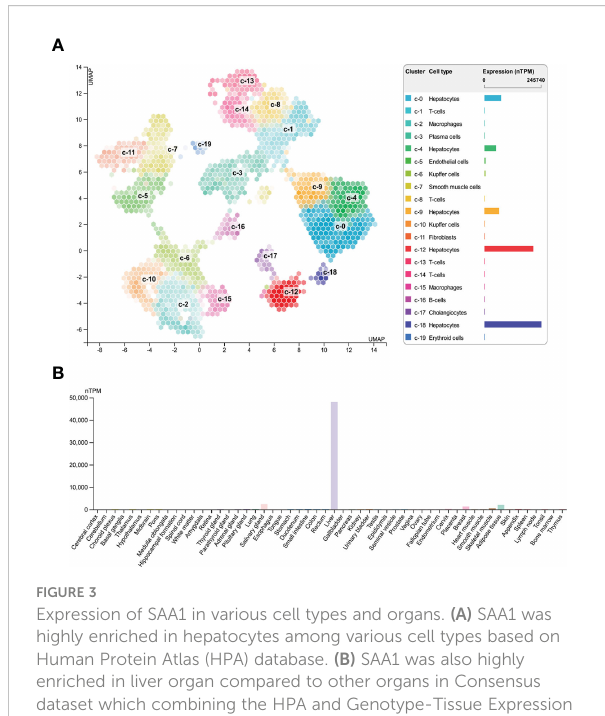
FIGURE 3 Expression of SAA1 in various cell types and organs. (A) SAA1 was highly enriched in hepatocytes among various cell types based on Human Protein Atlas (HPA) database. (B) SAA1 was also highly enriched in liver organ compared to other organs in Consensus dataset which combining the HPA and Genotype-Tissue Expression (GTEx)